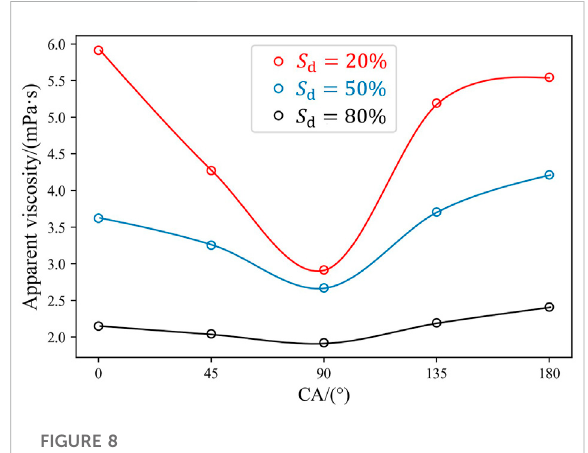
FIGURE 8 The effect of contact angle (CA) on apparent